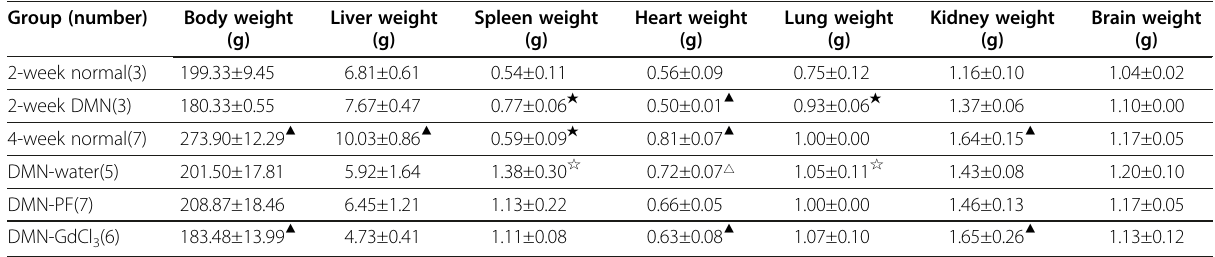
Table 1 Effects of PF on body weight and main organs weight in DMN-induced rat liver fibrosis ( (cid:1) x ± s) Group (number)